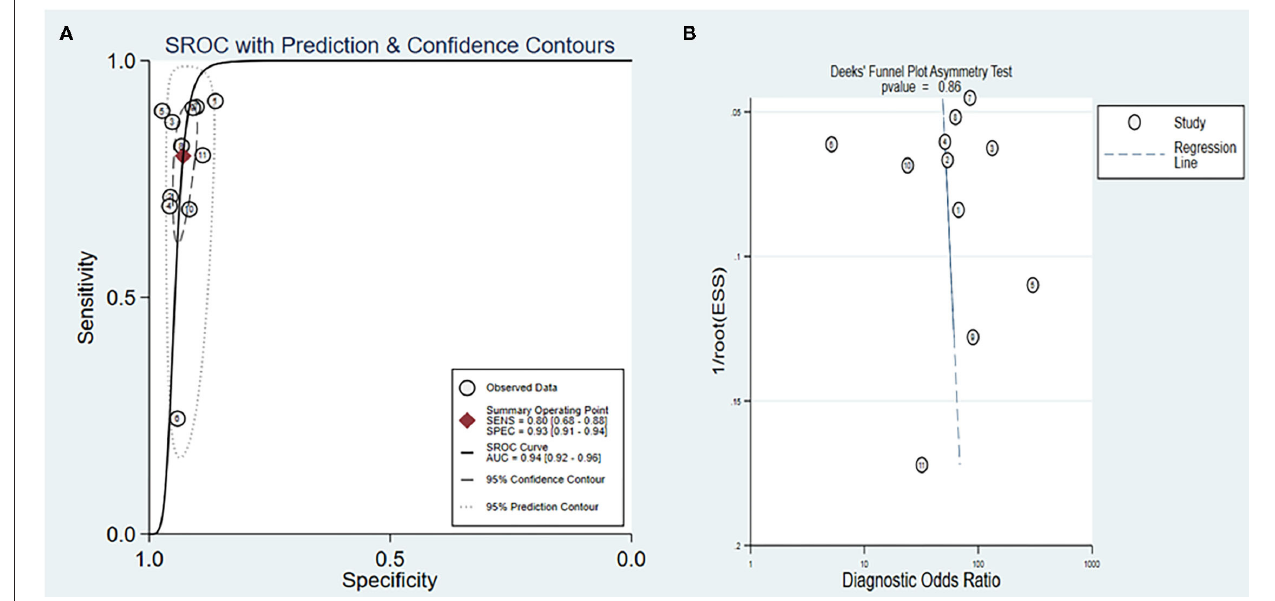
FIGURE 5 | (A) Summary ROC (SROC) curve for SDC2; (B) Deeks’ funnel plot asymmetry test for all studies included in this